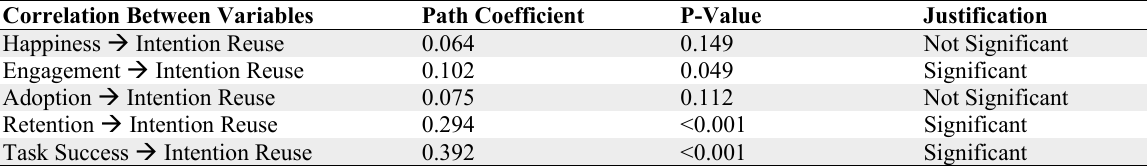
Measurement Path Coefficient Analysis Correlation Between Variables Path